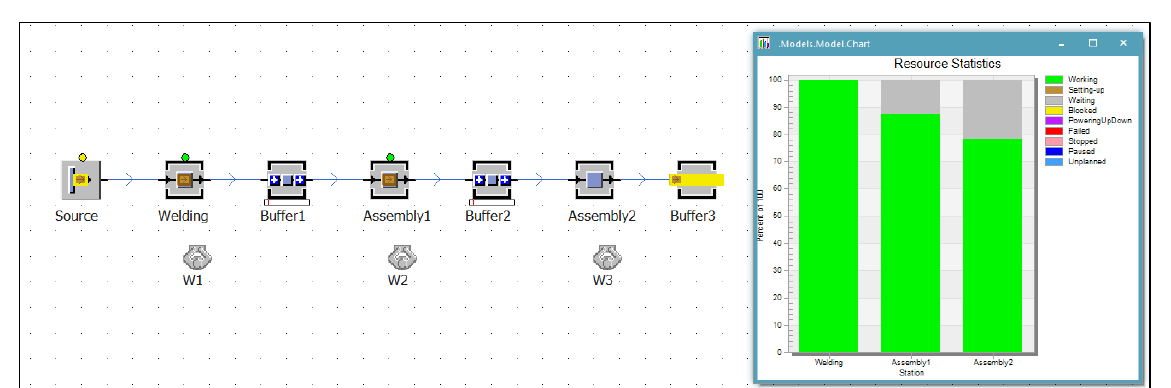
Figure 2. Current line state.